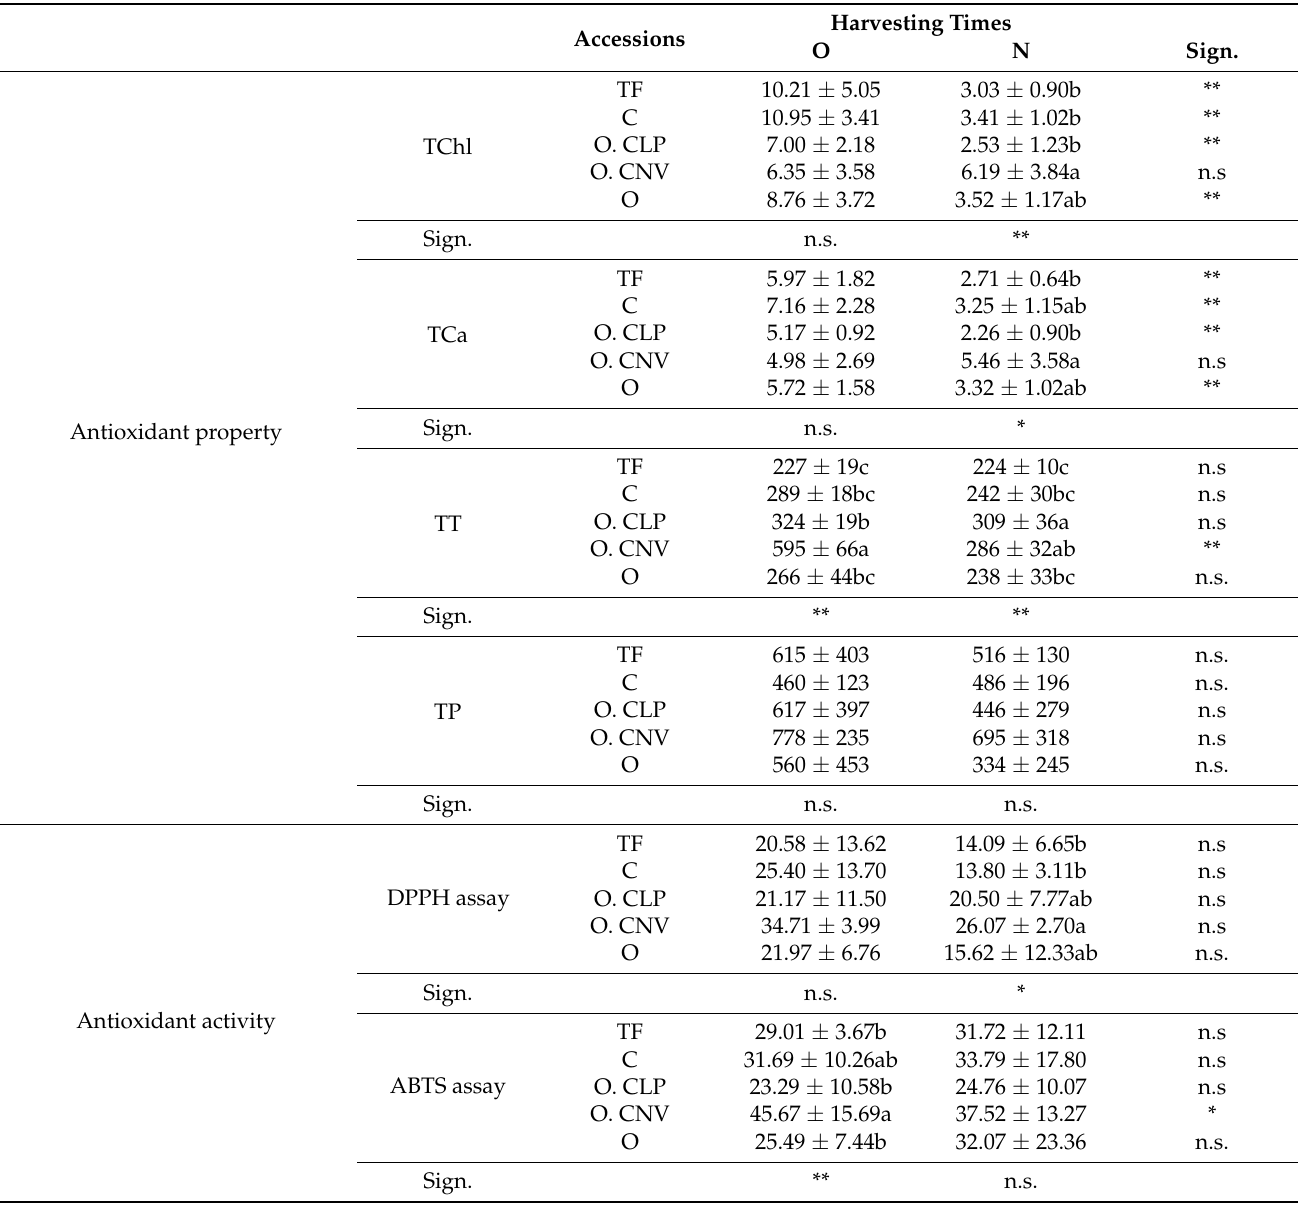
Table 3. Antioxidant composition and activity of Tonda di Filogaso (TF), Ciciarello (C), Ottobratica Calipa. (O. CLP) Ottobratica Cannav à (O. CNV) and Ottobratica (O)